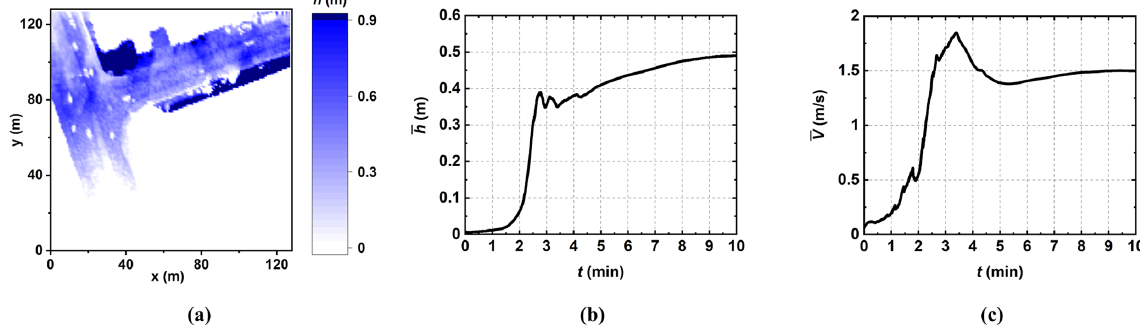
Figure 10. Outputs of the simulator generated after and during 10min of a single hydrodynamic run without pedestrian consideration plotted in terms of (a) floodwater depth map and temporal changes in the average floodwater in terms of (b) depth and (c) velocity.